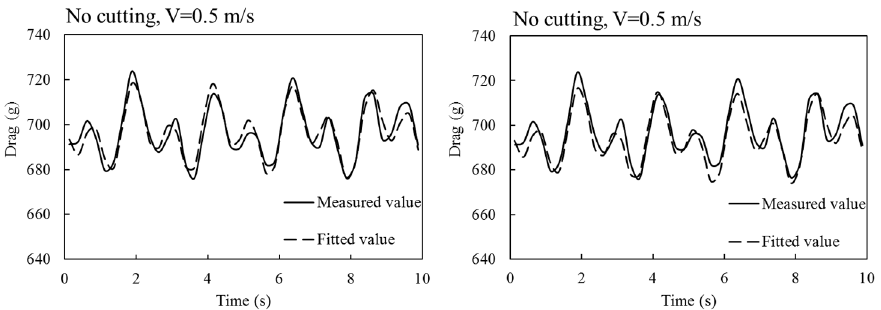
Figure 11. Comparison of the fitted value and the measured value of drag for codends with catch using different order Fourier series (an example: ( left ): using the second-order Fourier series; ( right ): using the third-order Fourier series). Table 3. Correlation of measured value and fitted value of codend drag by the Pearson product-moment correlation coefficient. Cutting